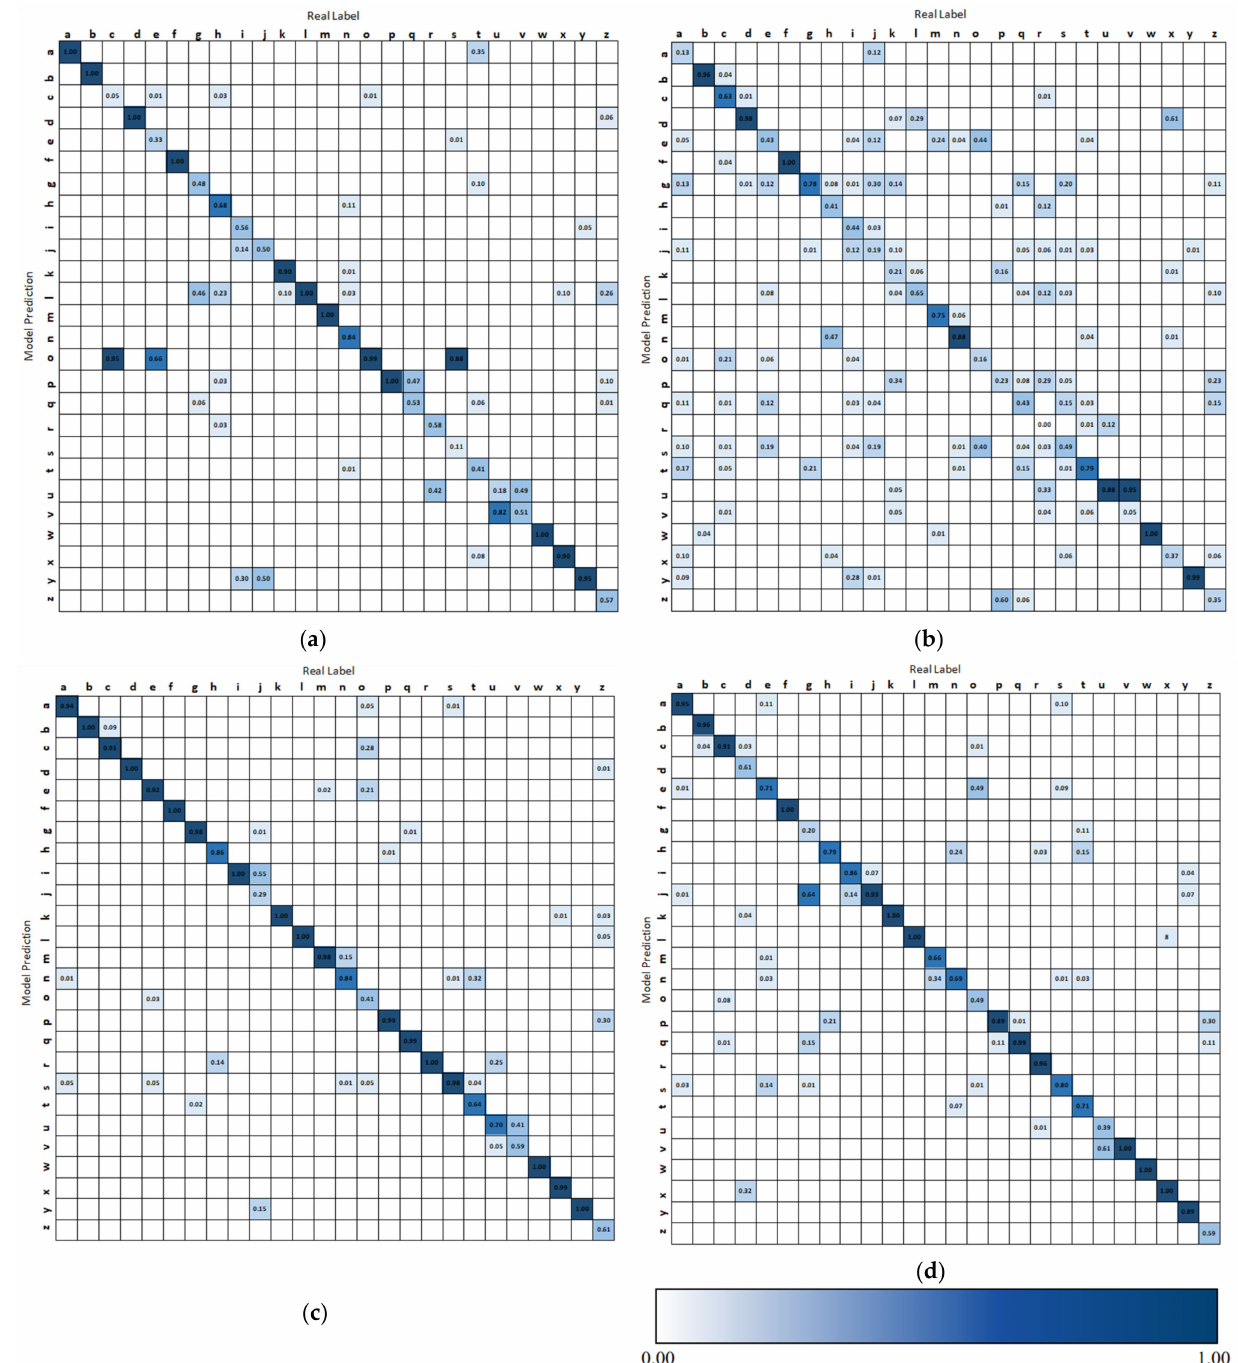
Figure 12. Accumulated confusion matrices of four participants. ( a ) Confusion matrix of all cases for participant 1. ( b ) Confusion matrix of all cases for participant 2. ( c ) Confusion matrix of all cases for participant 3. ( d ) Confusion matrix of all cases for participant